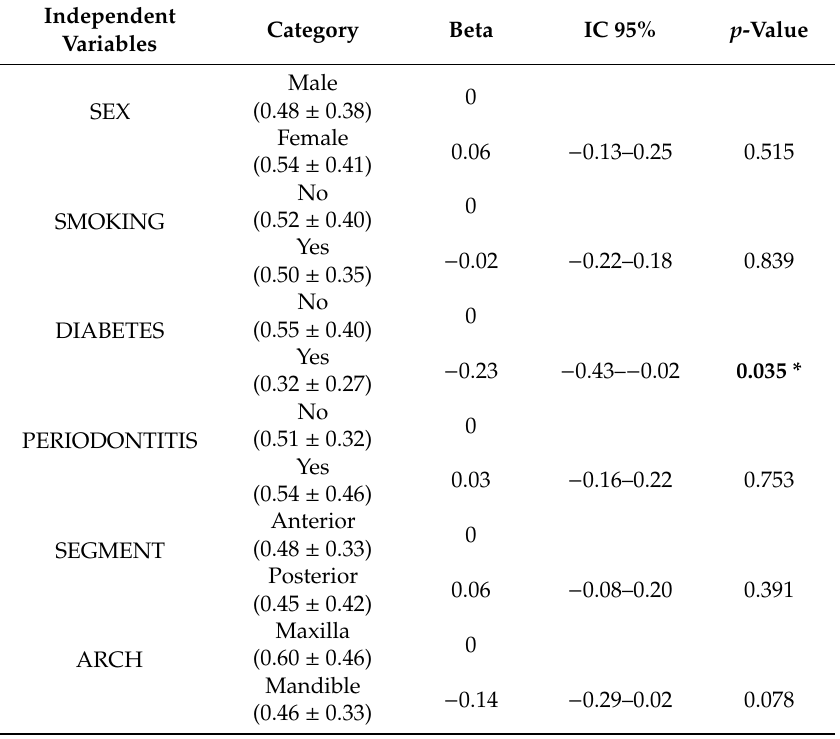
Figure 5. MBL vs. measured pocket depth.